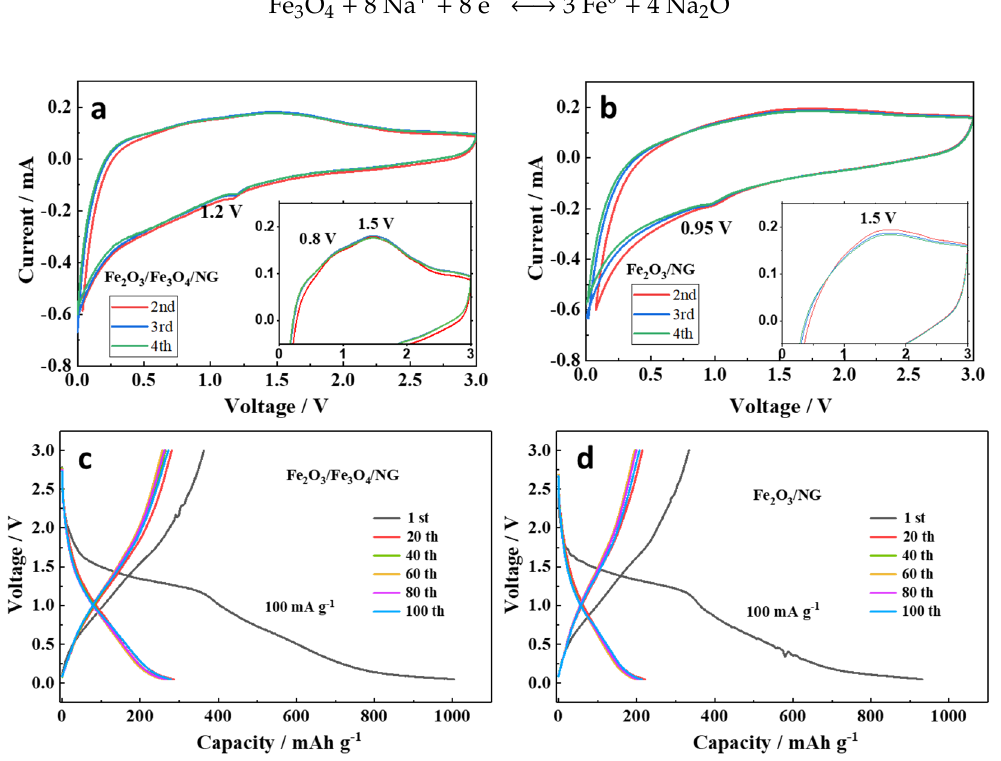
Figure 4. CV curves of ( a ) Fe 2 O 3 / Fe 3 O 4 / NG and ( b ) Fe 2 O 3 / NG anodes from the 2nd to 4th cycle at a scan rate of 1.0 mV s − 1 between 0.05 and 3 V vs. Na / Na + . Galvanostatic charge-discharge curves of ( c ) Fe 2 O 3 / Fe 3 O 4 / NG and ( d ) Fe 2 O 3 / NG anodes at a current density of 100 mA g − 1 .